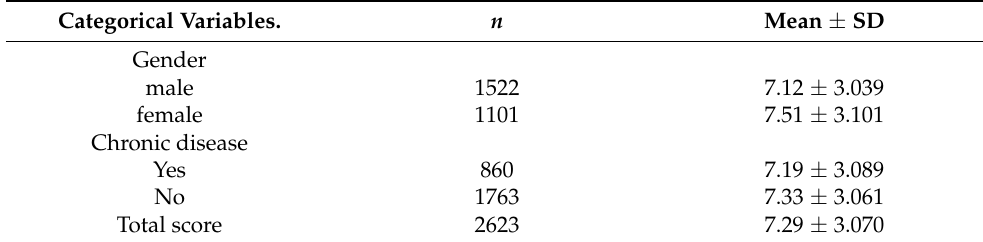
Table 3. Descriptive statistics of memory scores of categorical variables. Categorical Variables.